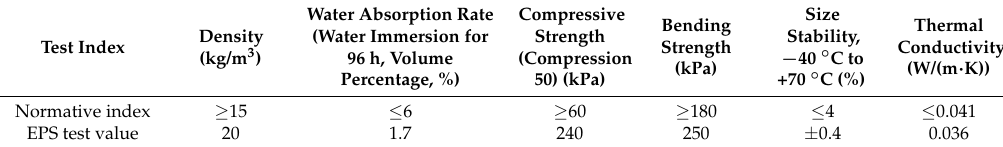
Table 2. Mechanical properties of the EPS.